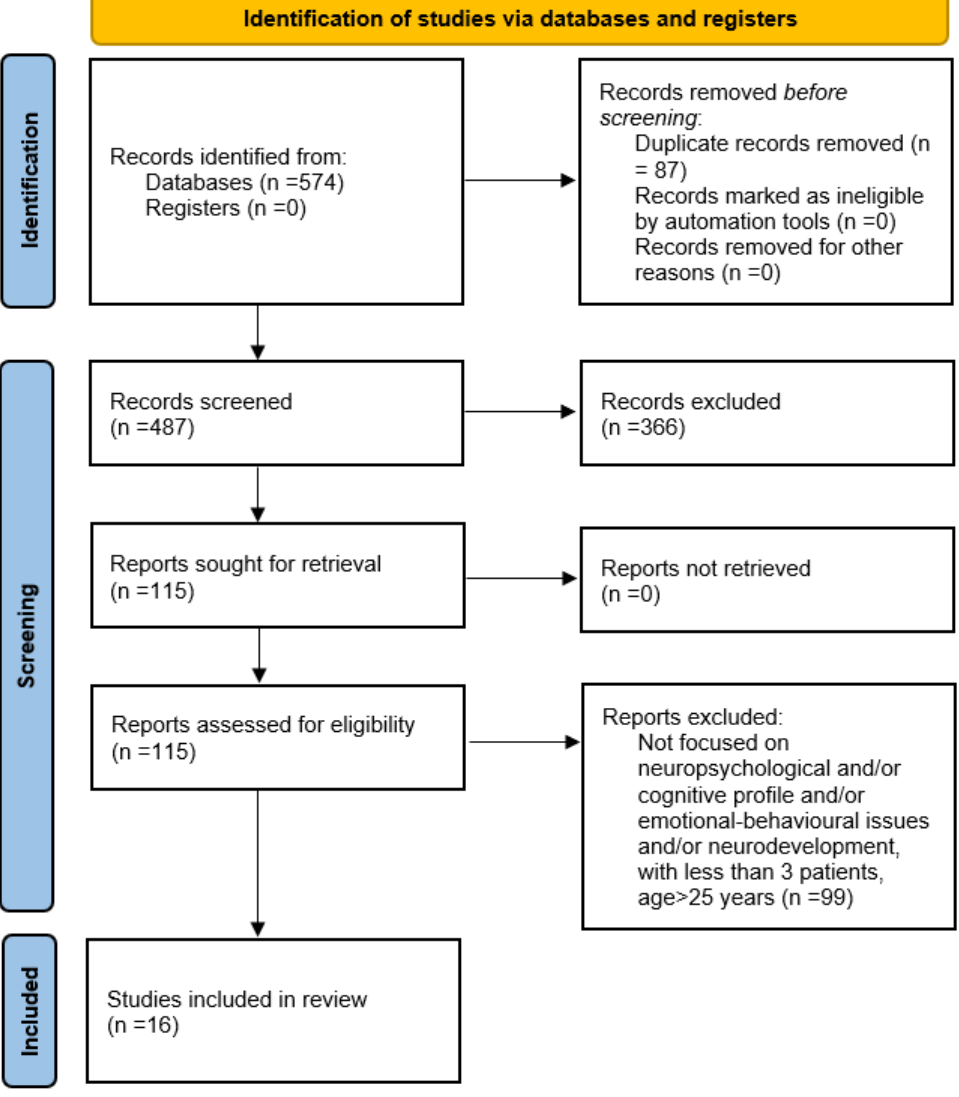
Figure 1.Selection process. Figure 1. Selection